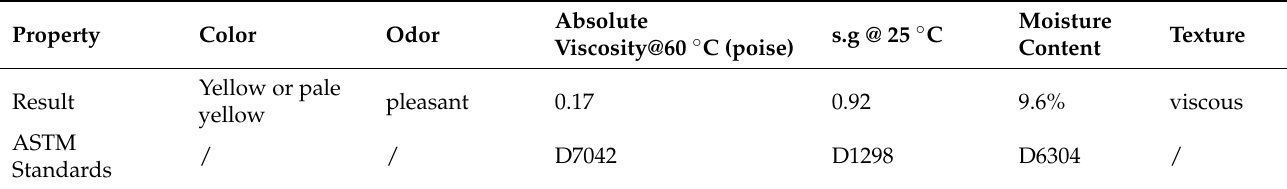
Table 10. Physical characteristics of DSO.